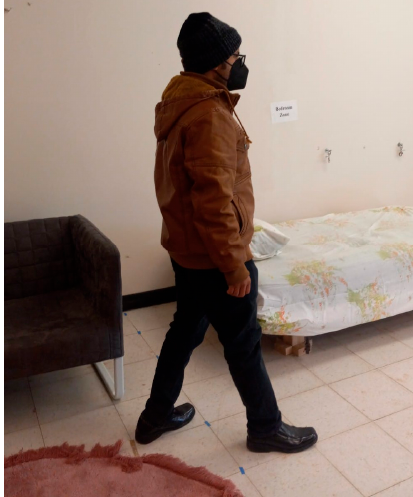
Figure 10. A participant lying in the bedroom zone.